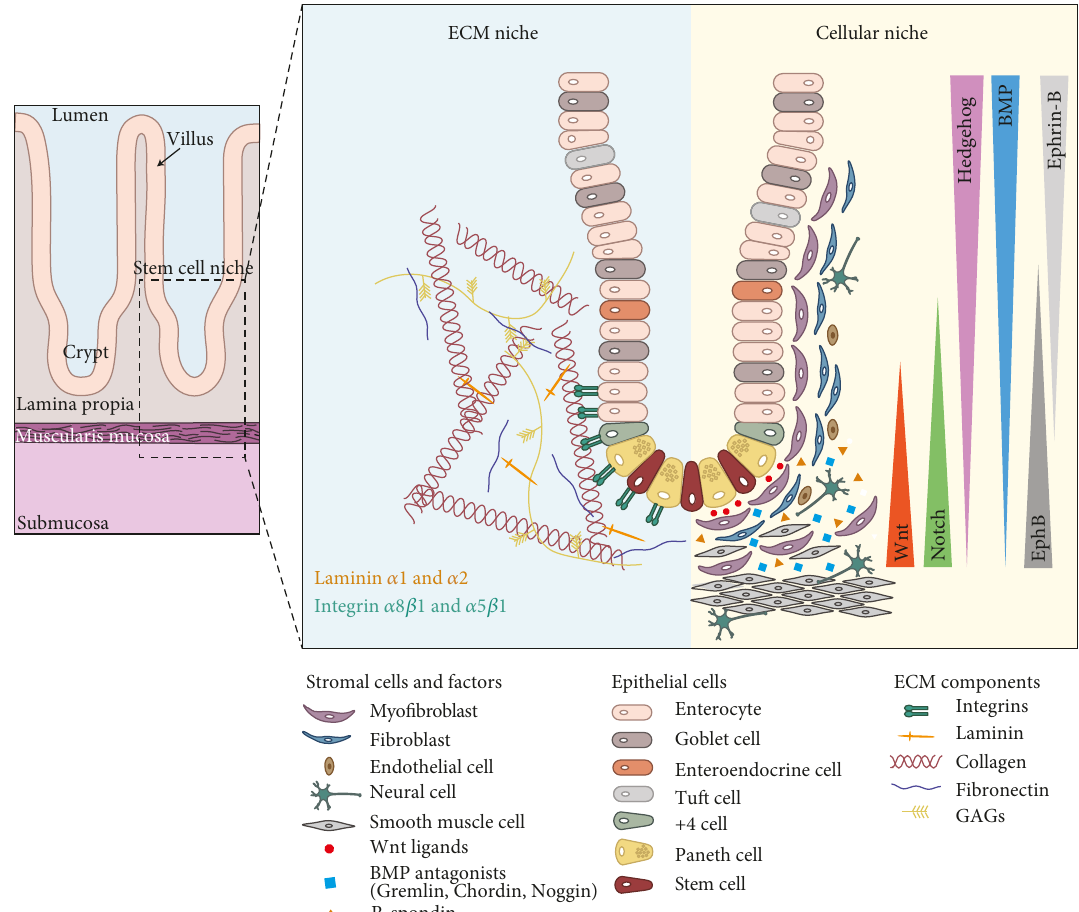
Figure 1: The intestinal stem cell niche. The intestinal epithelium comprises a monolayer of polarised columnar cells organised along the crypt-villus axis. Intestinal stem cells reside at the base of the crypts and continuously generate transit-amplifying (TA) daughter cells that di ff erentiate into various mature cells in the villi (enterocytes, goblet cells, enteroendocrine cells, tuft cells, or Paneth cells). The crypt surrounding microenvironment is made up of both physical/structural and cellular niche to regulate ISC homeostasis. The physical niche includes collagen fi bres, integrins, fi bronectin fi laments, laminins, and glycosaminoglycan, which form a highly structured network named as the extracellular matrix (ECM). The cellular niche includes pericryptal myo fi broblasts, fi broblasts, endothelial cells, neural cells, and smooth muscle cells. The ECM and cellular niche interact and communicate with each other via di ff erent signalling pathways such as the Wnt, Notch, TGF- β /BMP, Eph/ephrin, and Hedgehog pathways for stem cell